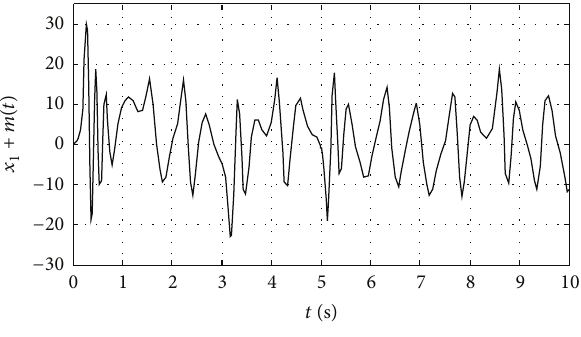
Figure 4: The masked sinusoidal signal.